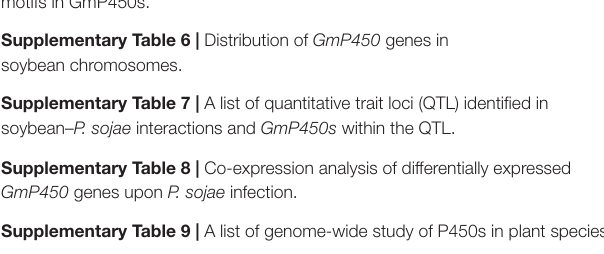
Supplementary Table 9 | A list of genome-wide study of P450s in plant species. Supplementary Table 10 | A list of characterized P450s in